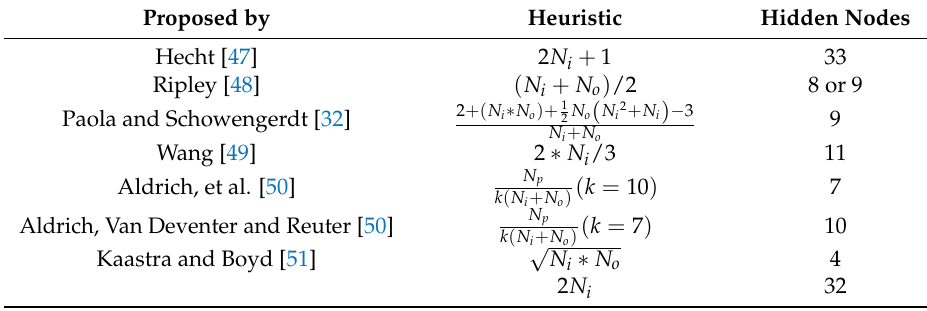
Table 4. The heuristics proposed by the package instructions to set the optimum number of variables for GBM and RF. ( N i : the total number of variables (i.e., 16 in this research)). Suggested Value Package mtry interaction.depth √ N i , but often the search space is set between 1 and gbm N.A √ N i = 4 N.A ranger xgboost 6 6 H 2 O 2 to 8 2 to 8 √ N i = 4 N.A randomForest